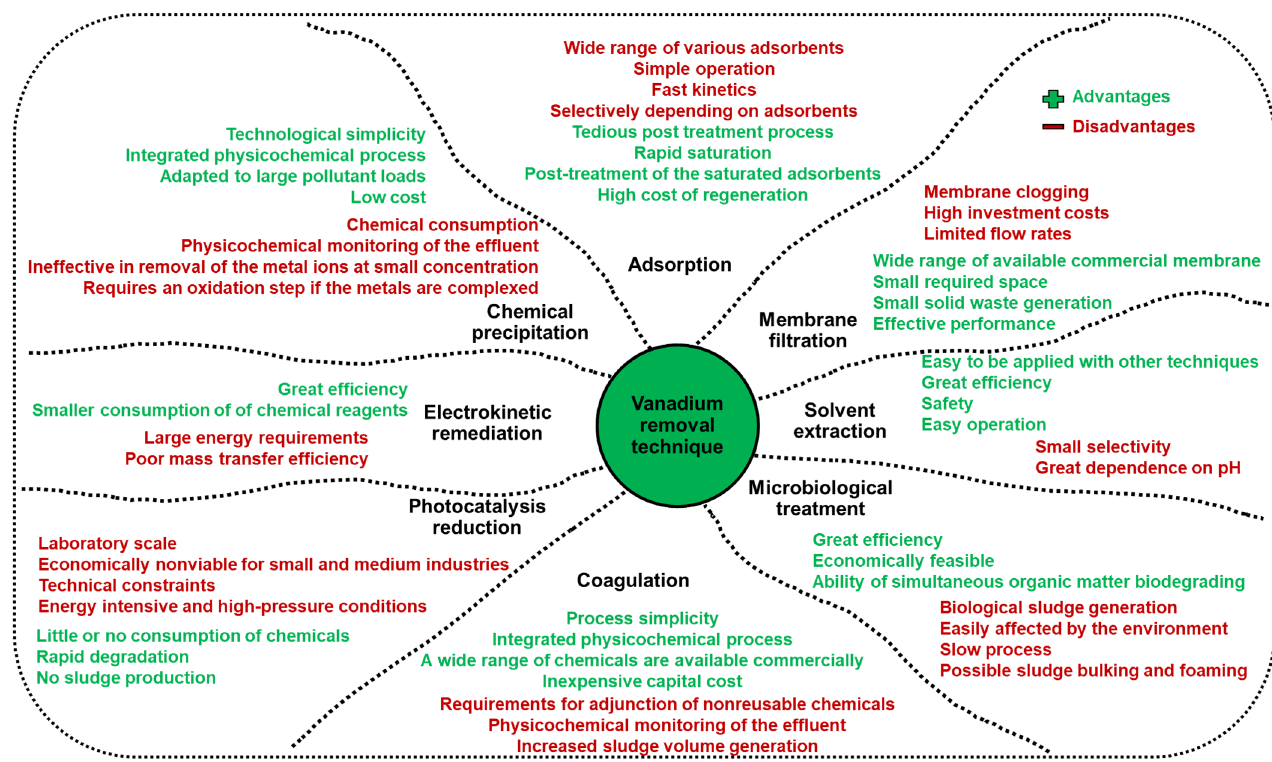
Figure 2. Comparison of treatment technologies for the vanadium removal from wastewaters.